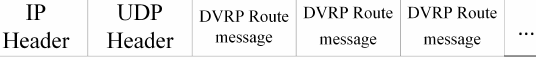
Figure 4: Main Routing Table